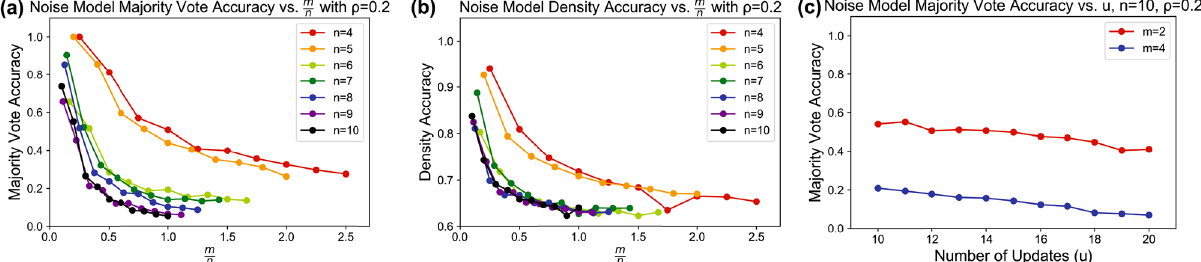
Figure 8. Effective QHAM Capacity using ibmq_16_melbourne noise model. ( a ) Majority vote accuracy for the QHAM for memories of length n from the same test conditions as ( a ) versus m n . ( c ) Demonstration of tuning for u . In this case, the optimal u based on majority vote accuracy is 11 for m